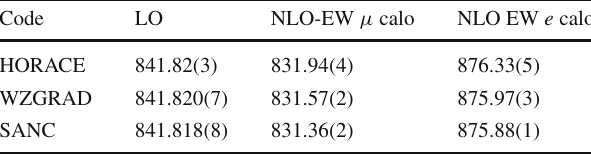
Table 14 pp → W + → l + ν l cross sections (in pb) at the 8 TeV LHC, with LHCb cuts and “calorimetric” leptons